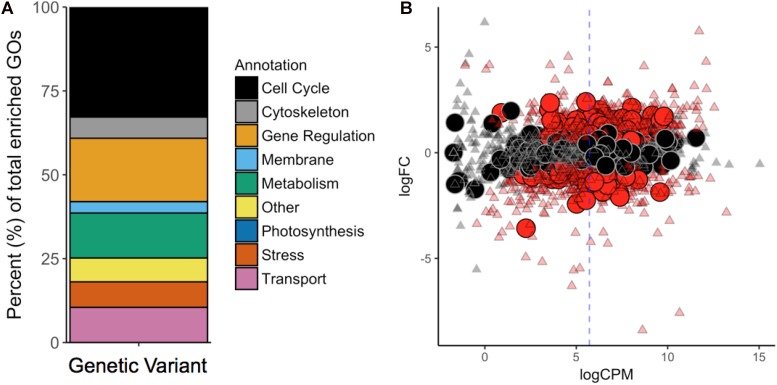
(A) GO-Term (GO) enrichment analysis revealed the cellular functions most affected by mutations. Each GO was manually revised and attributed to one of the nine categories contained in the legend. (B) Differential gene expression in G. sulphuraria RT22 orthologs in G. sulphuraria 074W (reciprocal best blast hit), here measured as log -fold change (logFC) vs. transcription rate (logCPM). Differentially expressed genes are colored red (quasi-likelihood F-test, Benjamini-Hochberg, p <= 0.01). Genes affected by variants are shown by large circles. Genes without significant differential expression are represented by triangles. The blue dashes indicate the average logCPM of the dataset. The orthologs in G. sulphuraria 074W of genes affected by variance in G. sulphuraria RT22 did not show more, or less, differential expression under fluctuating temperature.